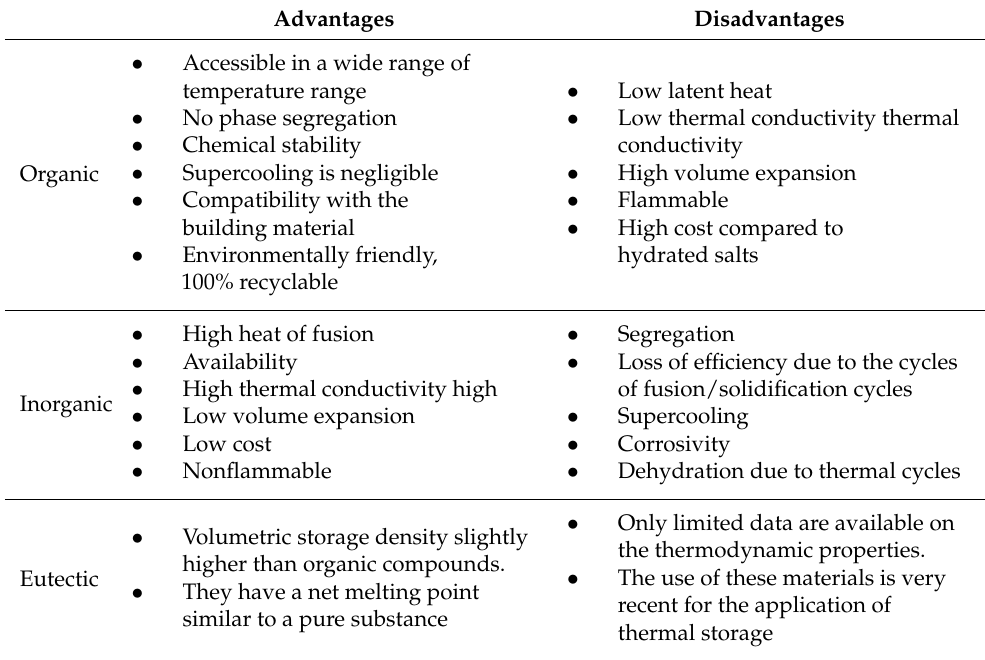
Table 1. Benefits and drawbacks of the different